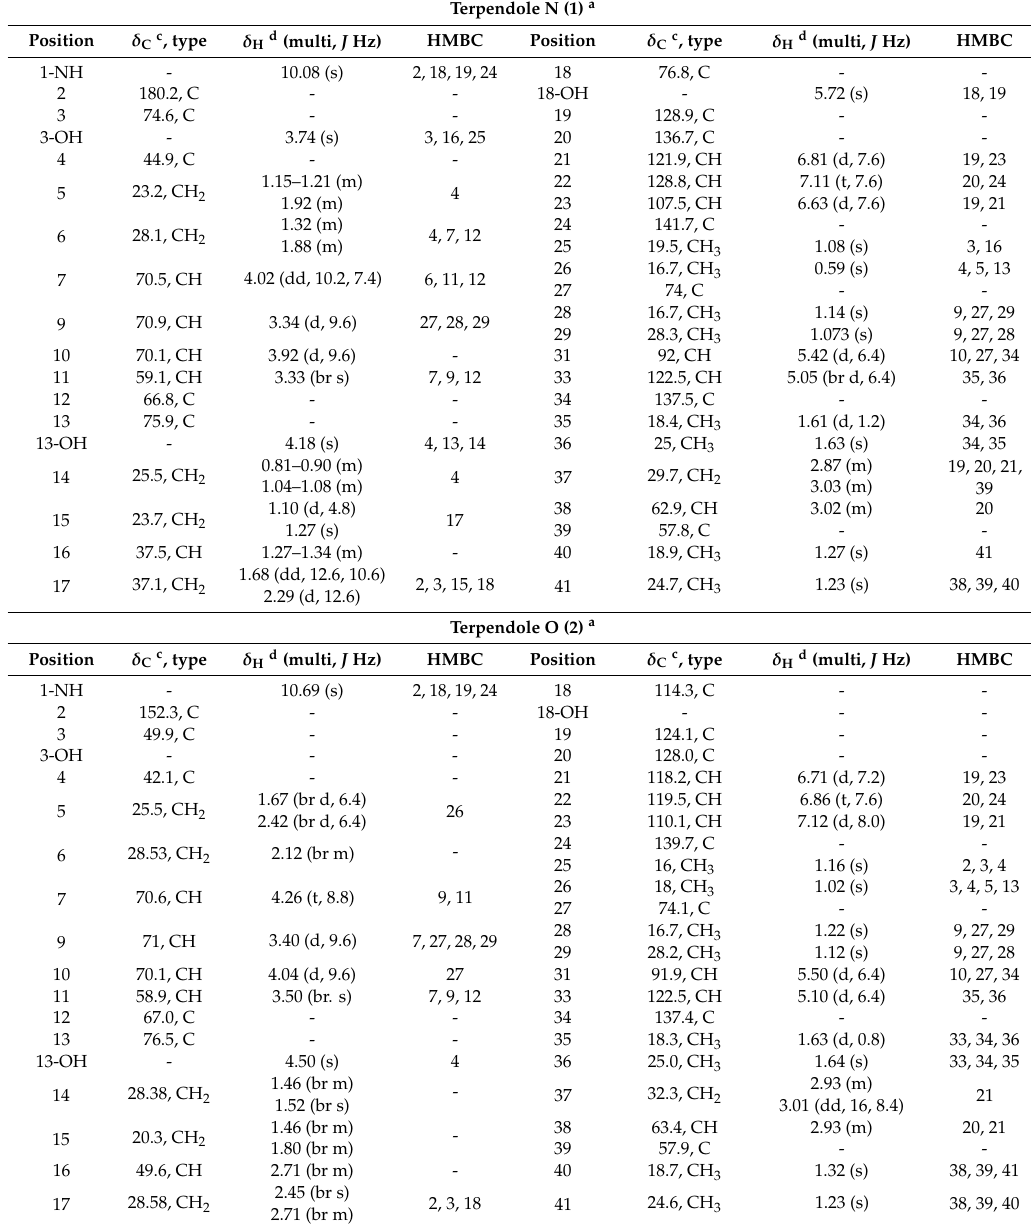
Table 2. 1 H- and 13 C-NMR chemical shifts of 1–3 in DMSO- d 6